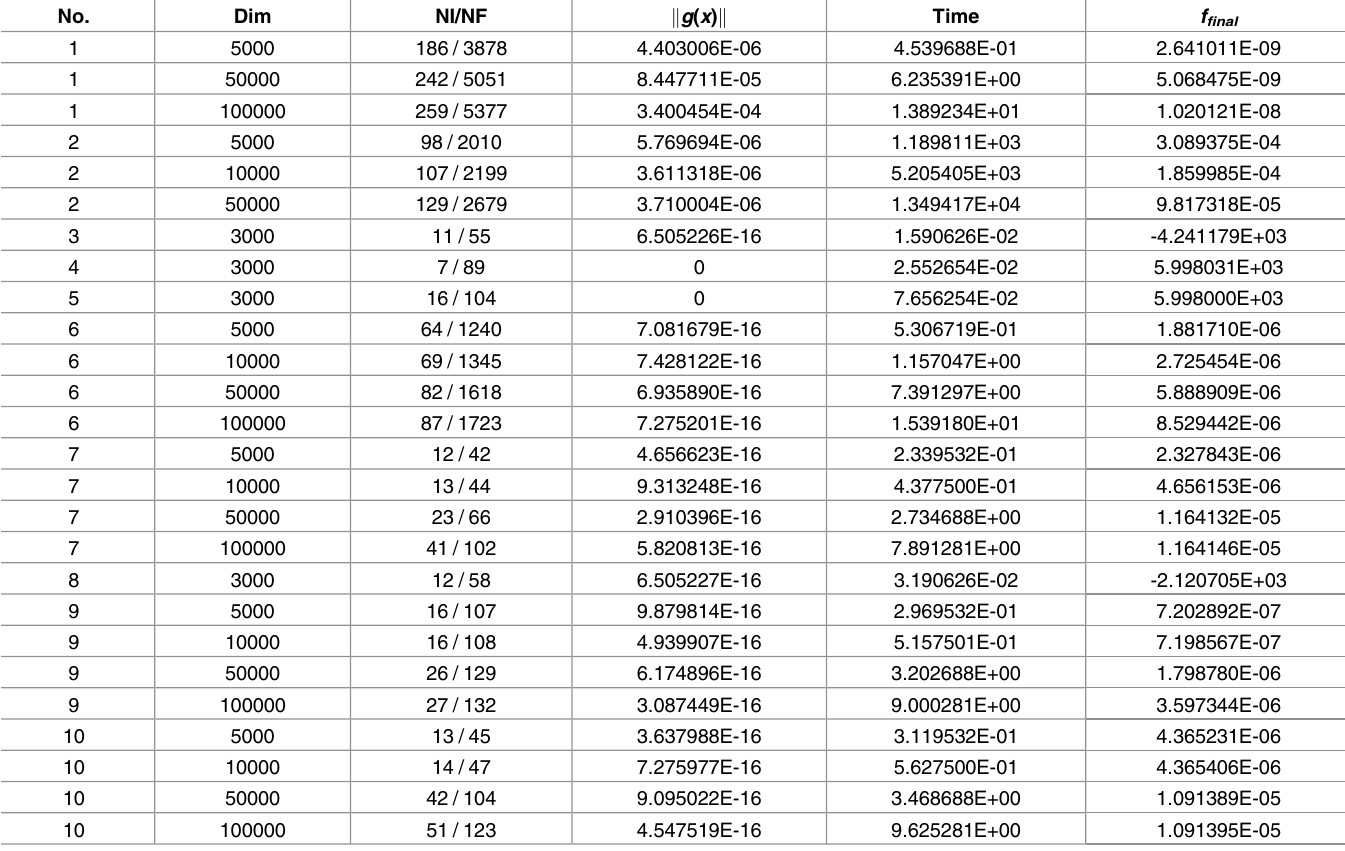
Table 3. Test results for Algorithm